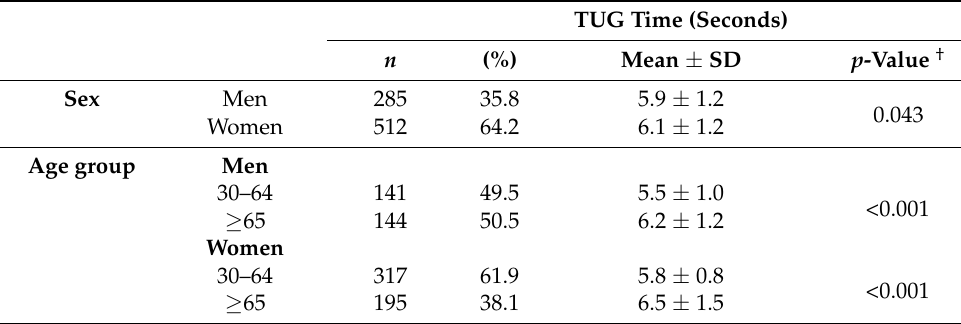
Table 2. Mean difference in TUG time by sex and age group.